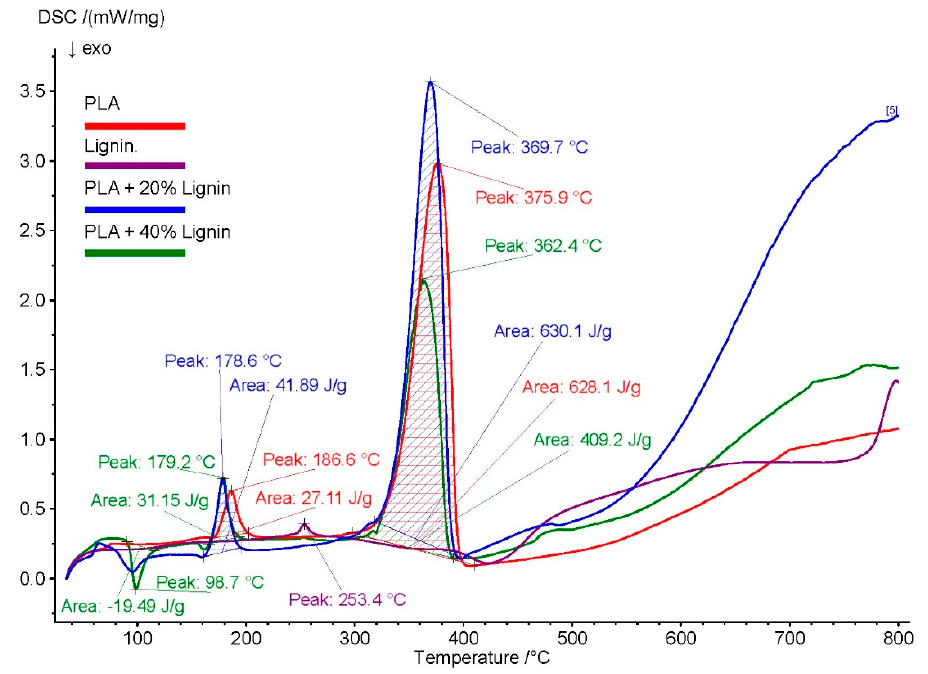
Figure 2. Di ff erential scanning calorimetry (DSC) thermographs of Lignin, PLA, Figure 2. Differential scanning calorimetry (DSC) thermographs of Lignin, PLA, and PLA/lignin and PLA / lignin biocomposites .